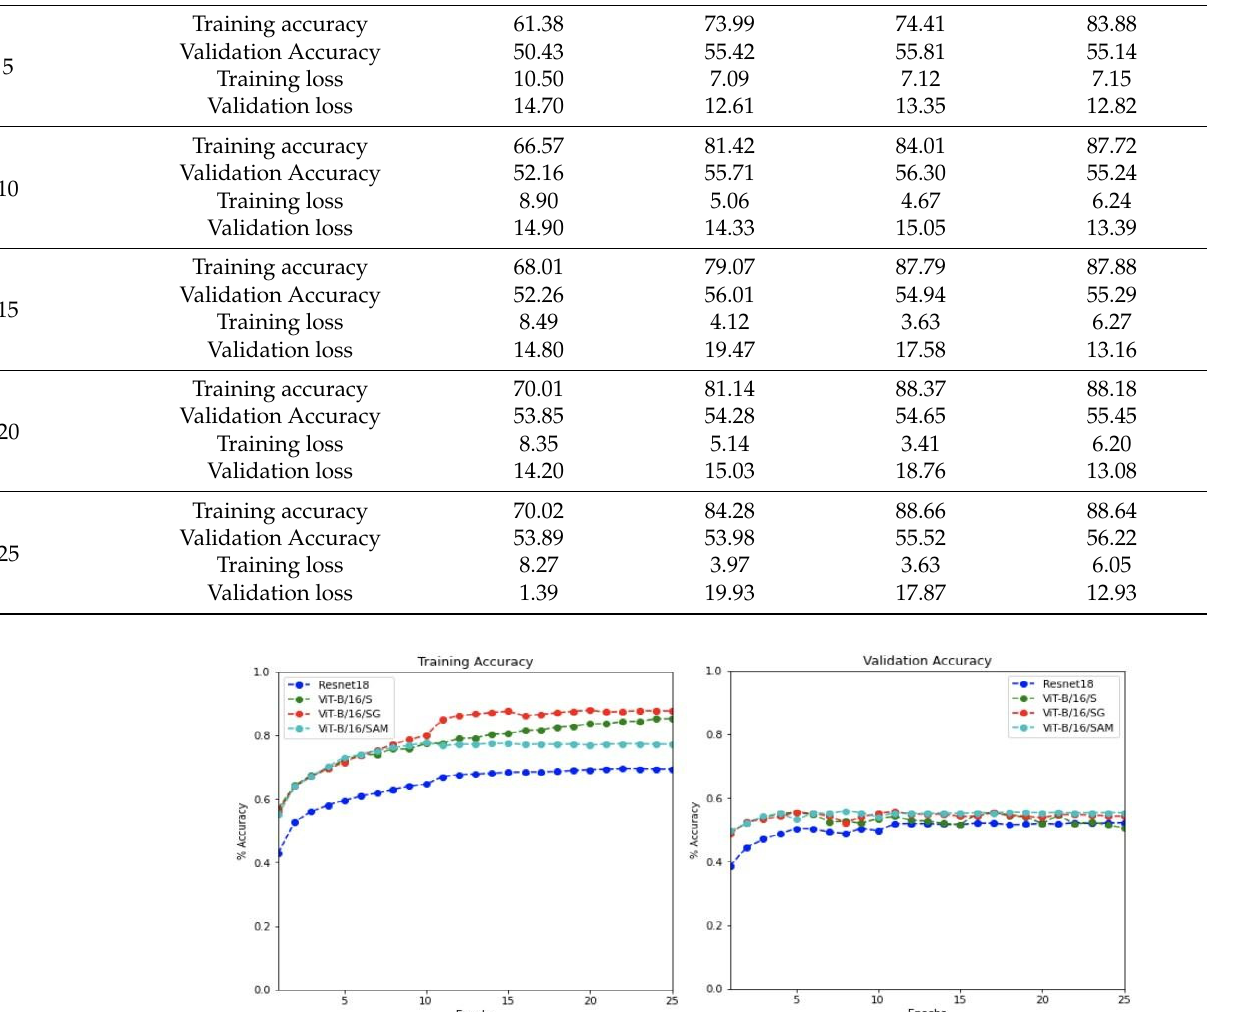
Figure 10. Training and validation accuracy for ResNet-18 vs. ViT-B/16 models.